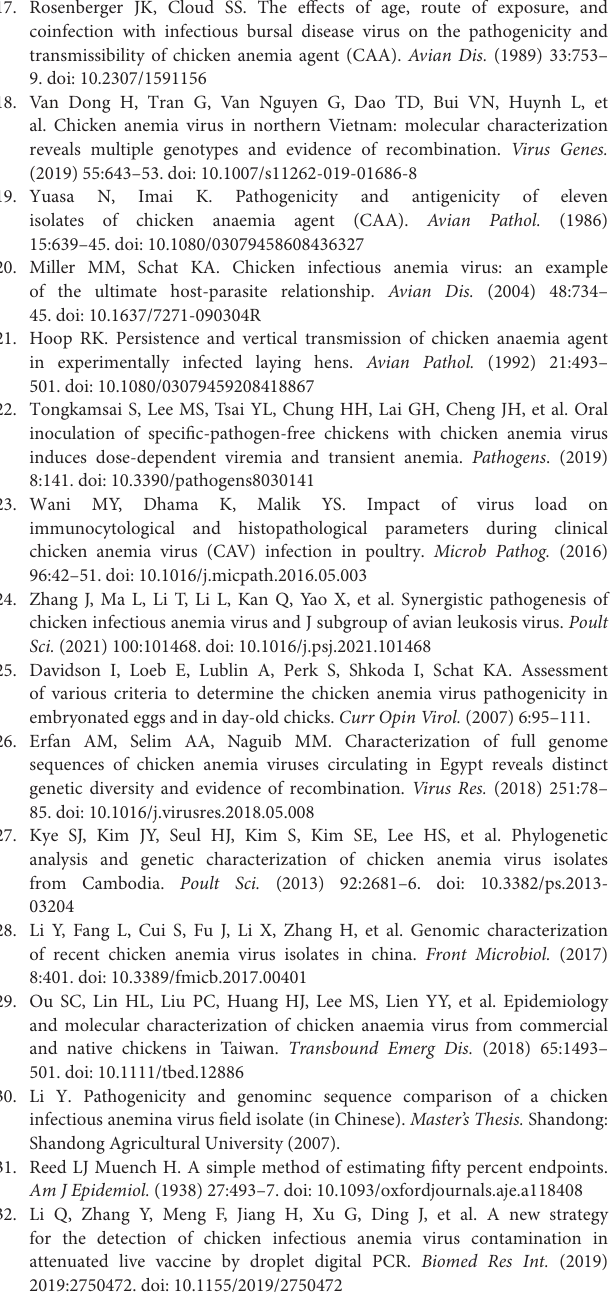
Supplementary Figure 2 | Phylogenetic analysis of various CAV strains based on VP1 amino acid (AA) sequences. The VP1 AA sequences of the YN04 strain, along with 45 CAV VP1 AA sequences downloaded from the GenBank database,